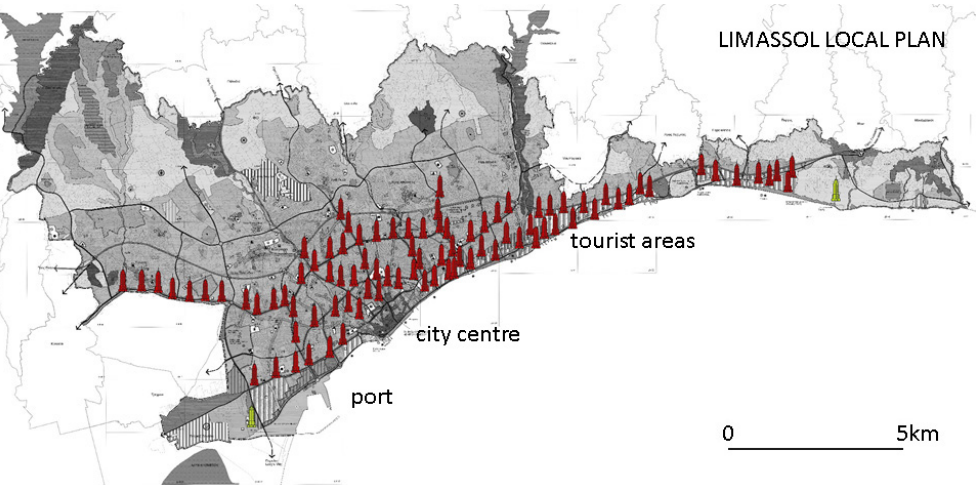
Figure 1. Exercise of possible high-rise LUD locations using Limassol Local Plan as background. Source: Ioannou and Nicolaou